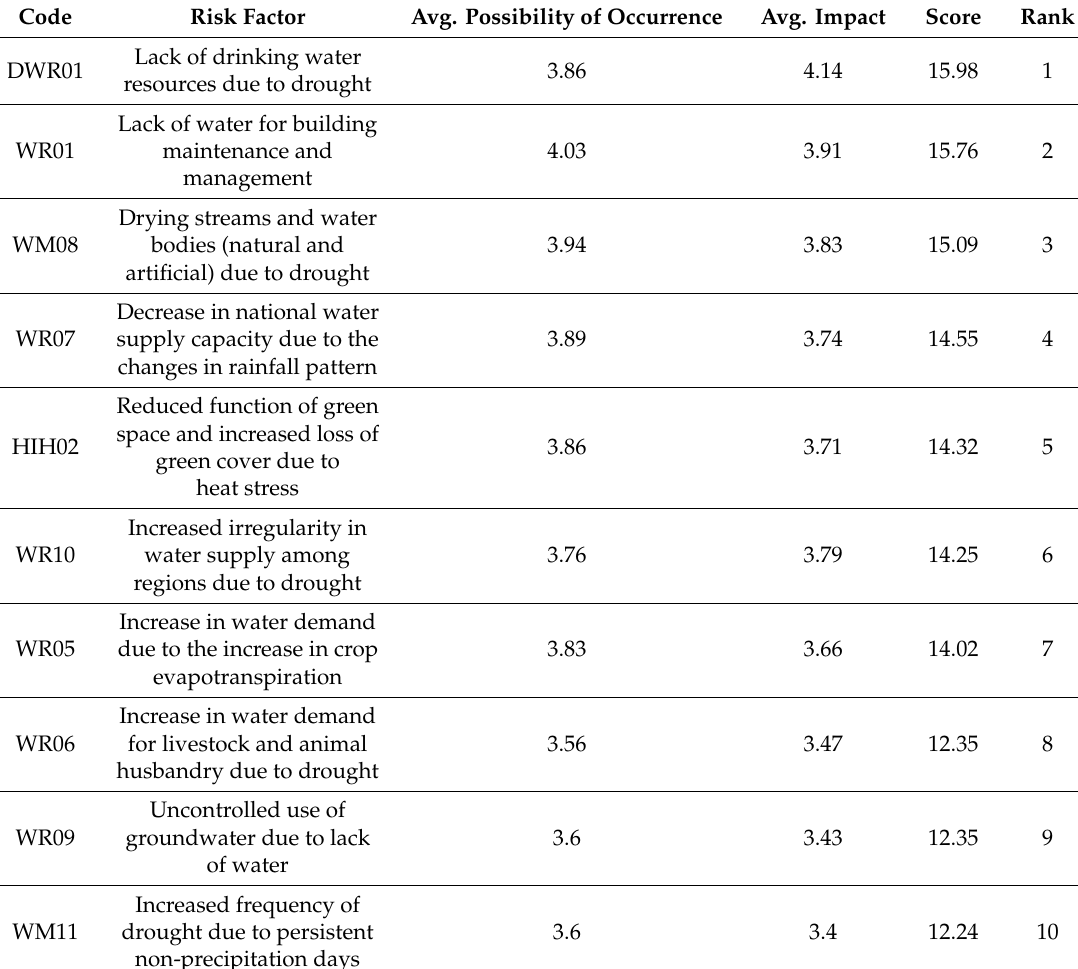
Table 3. Rank of risk